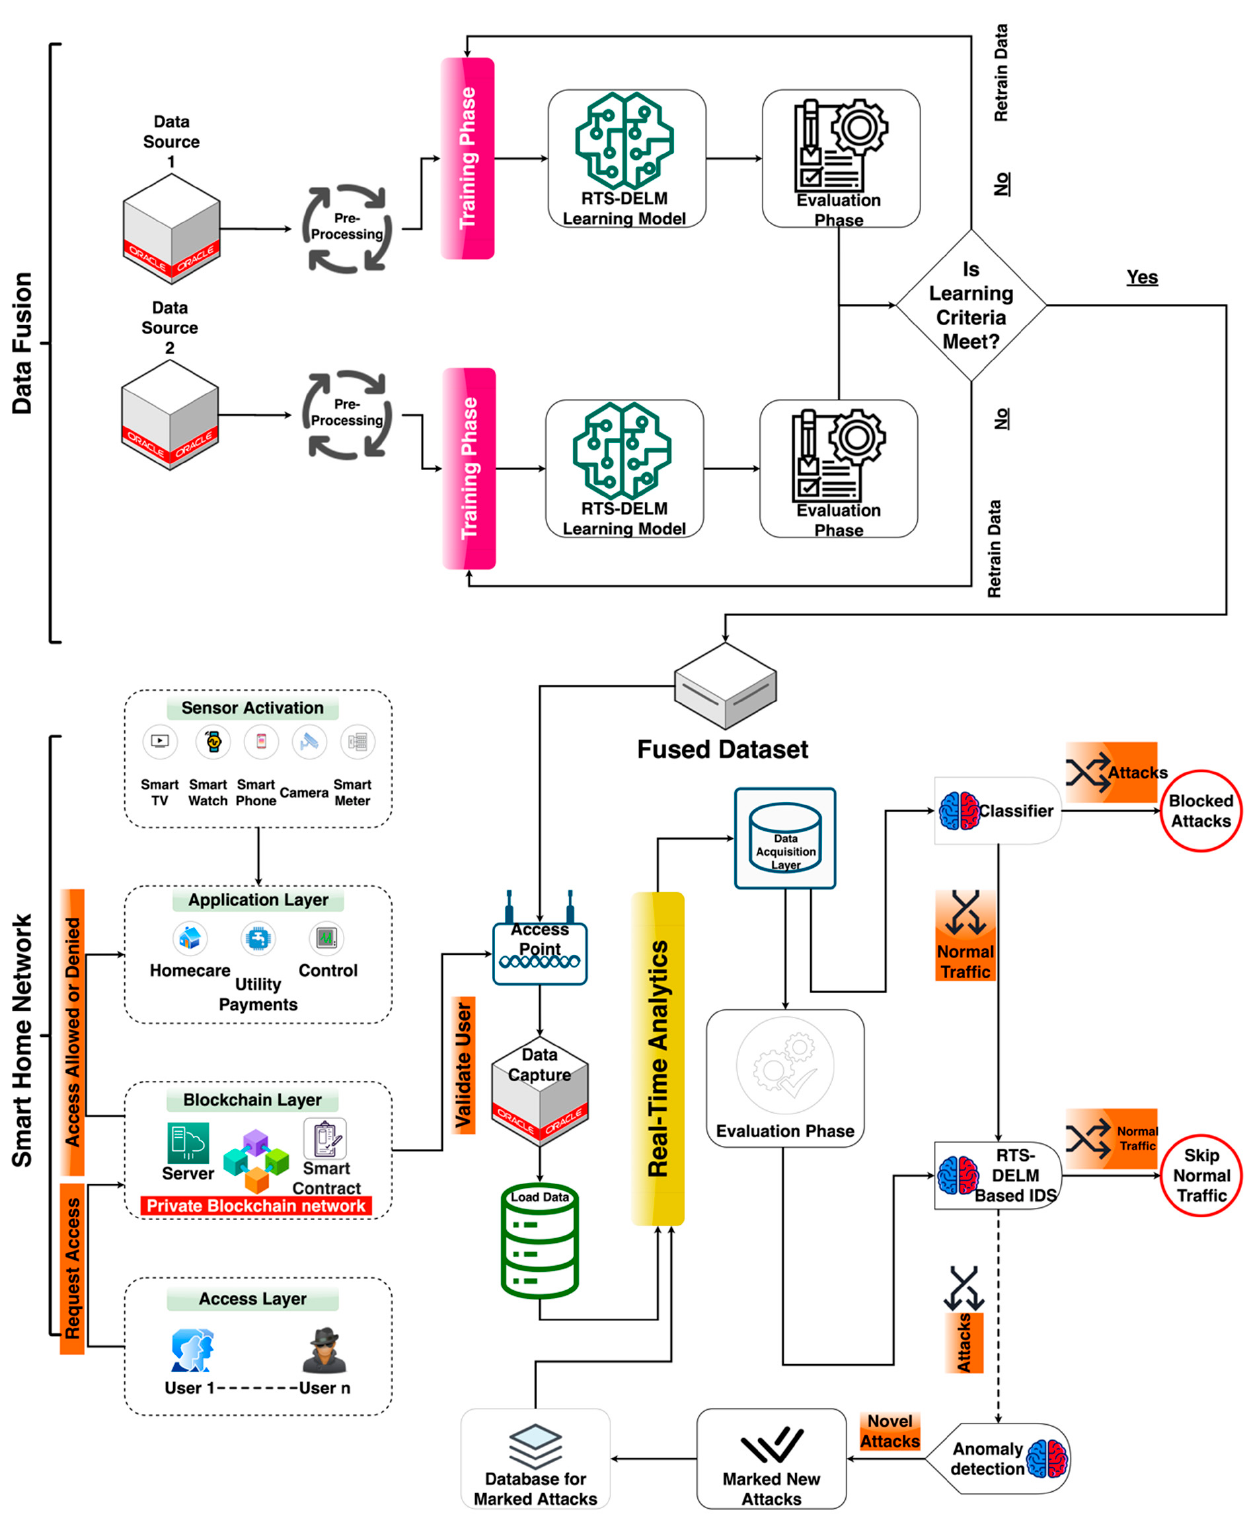
Figure 1. A proposed blockchain-based smart home network.